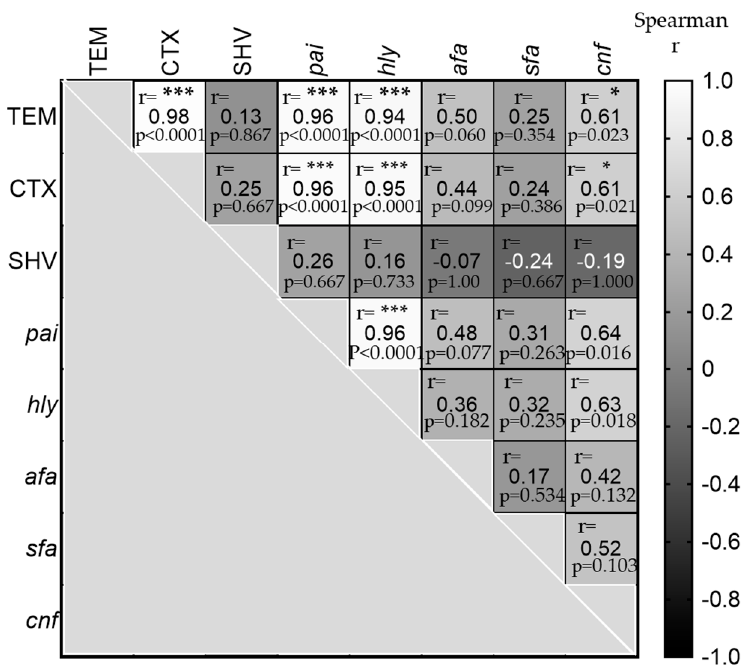
Figure 5. Correlation analysis among the antibiotic-resistant genes with virulence factors of UPEC infection. The heatmap shows the relationship among the antibiotic-resistant genes and virulence factors of UPEC infection, using computed nonparametric Spearman correlation. The white cells are highly positively correlated between these genes, r > 0.90 and significance were considered when the p -value was < 0.0001 (***). At the same time, the light gray colors are moderate positively correlated, with r between 0.60–065 and a p -value < 0.05 (*). On the other hand, the darker gray cells are not significant found. Keys: Gene markers include pai : pathogenicity island, hly : hemolysin, sfa : S-fimbrial adhesion, cnf-1 : cytotoxic necrotizing factor-1, and afa : a fimbrial adhesion.